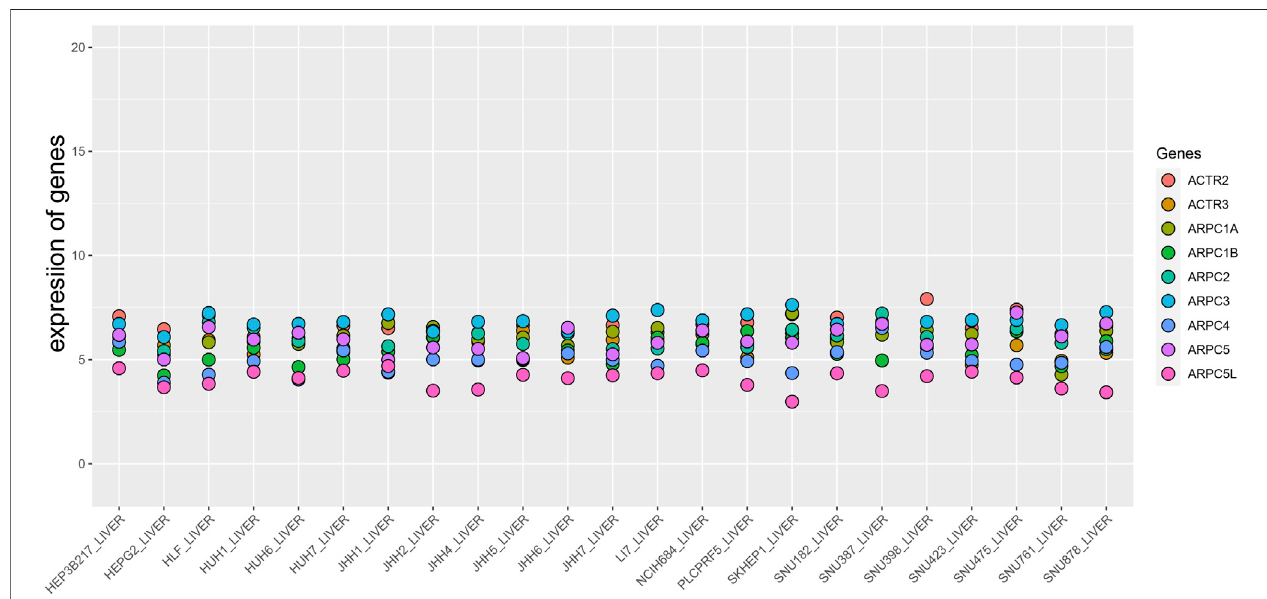
FIGURE4| ExpressionlevelofArp2/3complexmembersinHCCcelllines(theCCLE database). Theabscissarepresents differentHCCcelllines,andtheordinate is the expression value of genes.